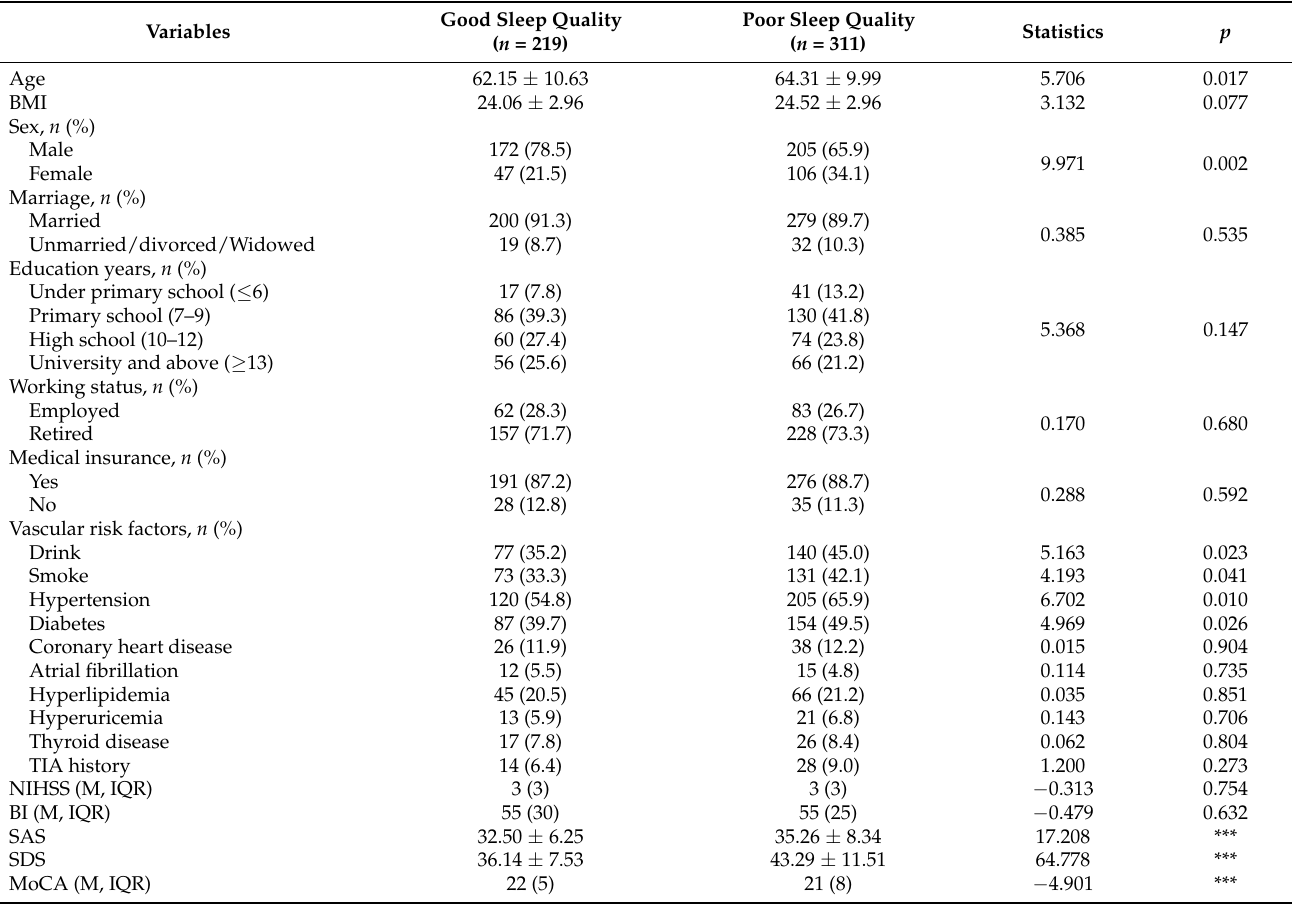
Table 1. Sociodemographic characteristics of the participants ( n = 530).